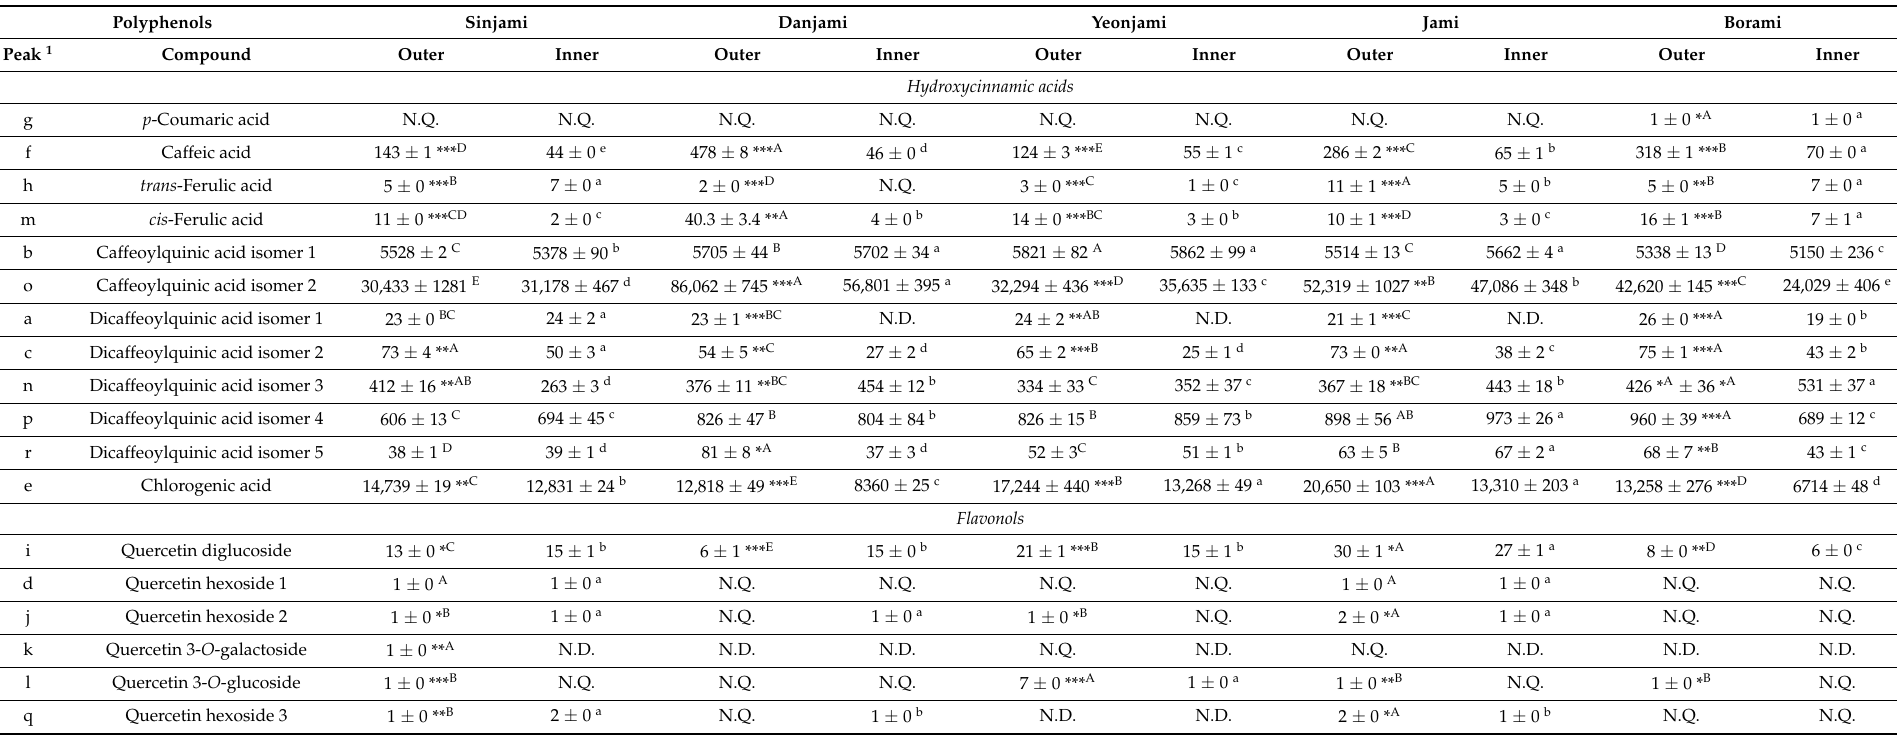
Table 3. Phenolic content in the outer and inner layers of five purple sweet potato cultivars by ultra-high-performance liquid chromatography-positive electrospray-triple quadrupole (UHPLC-(ESI)-QqQ) (mg/kg DW). Polyphenols Outer Inner Outer Inner Outer Inner Outer